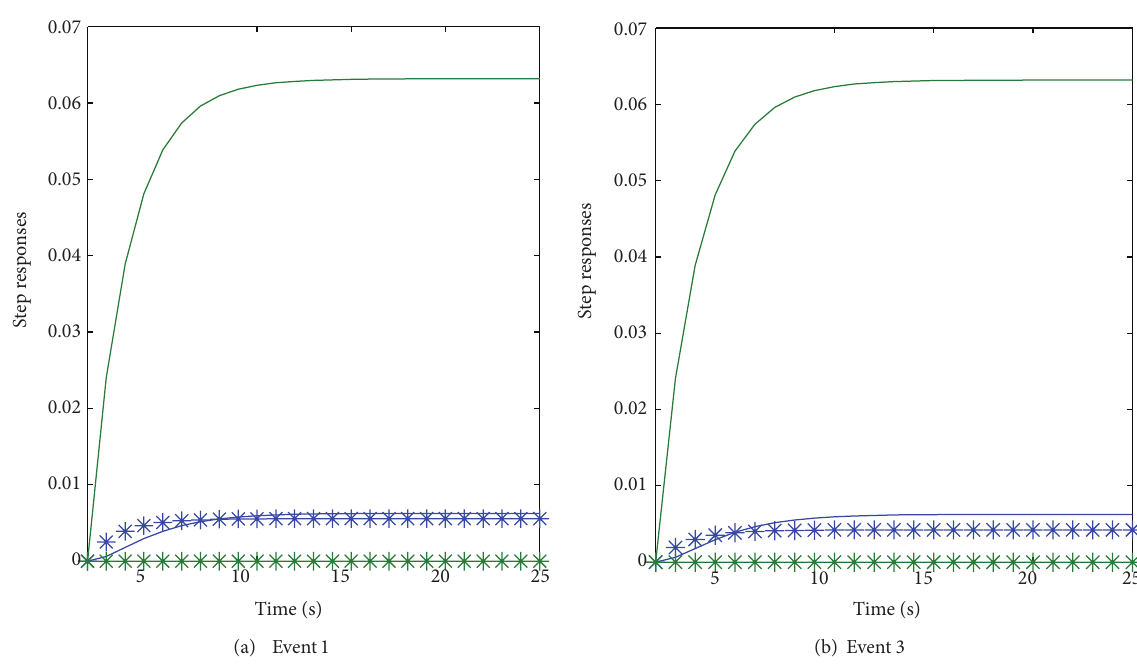
Figure 5: Step responses under different discrete